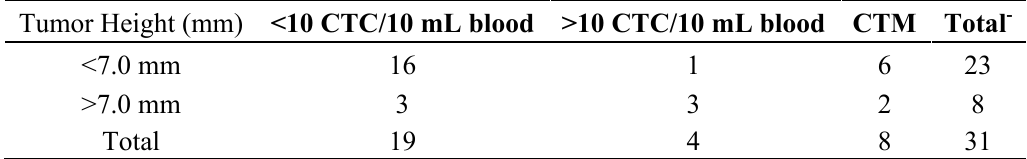
Table 3. Correlation of CTC count with tumor height.